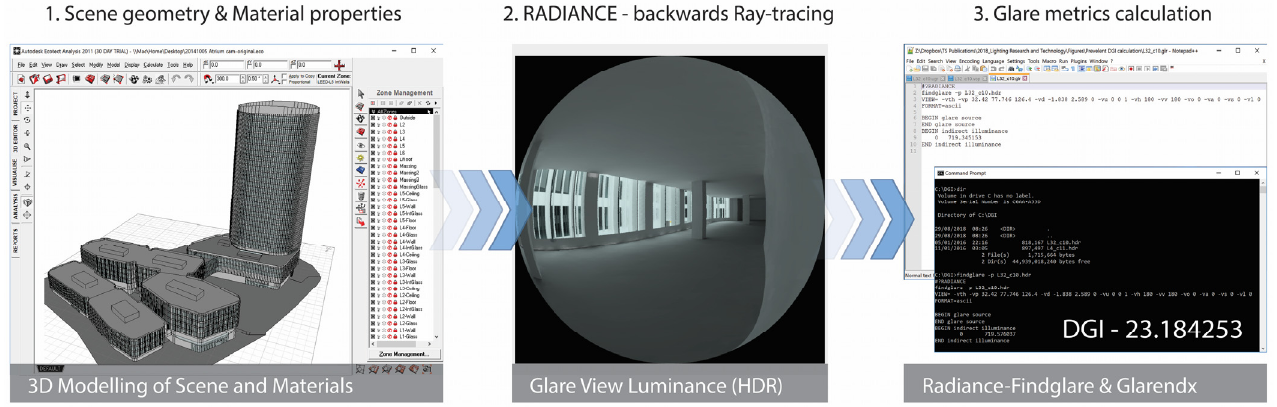
Figure 1. Prevalent 3-stage process to calculating common glare metrics via thresholding algorithms.